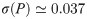
Distribution of fitness values, ω(P), obtained by the folding and docking procedure for an evolved sequence.The distribution is based on 103 measurements. The solid line is a fit to a Gaussian distribution with width σ(P)≃0.037. Similar results are obtained for mutated sequences with lower mean fitness.